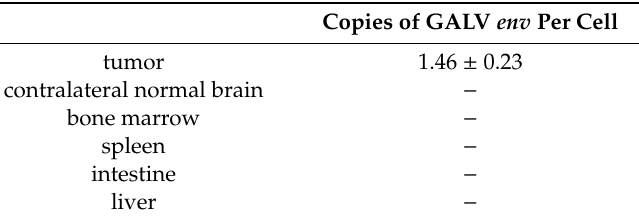
Table 1. Biodistribution of GS4-GFP after intratumoral injection of the vector in immune-competent intracerebral glioma model. Copies of GALV env Per Cell tumor 1.46 ± 0.23 contralateral normal brain bone marrow − liver